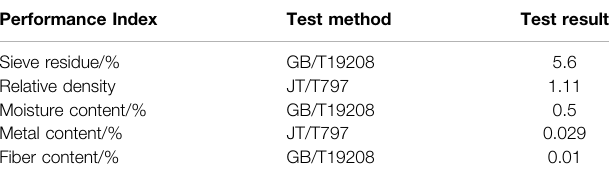
TABLE 2 | Main performance indexes of rubber powder.